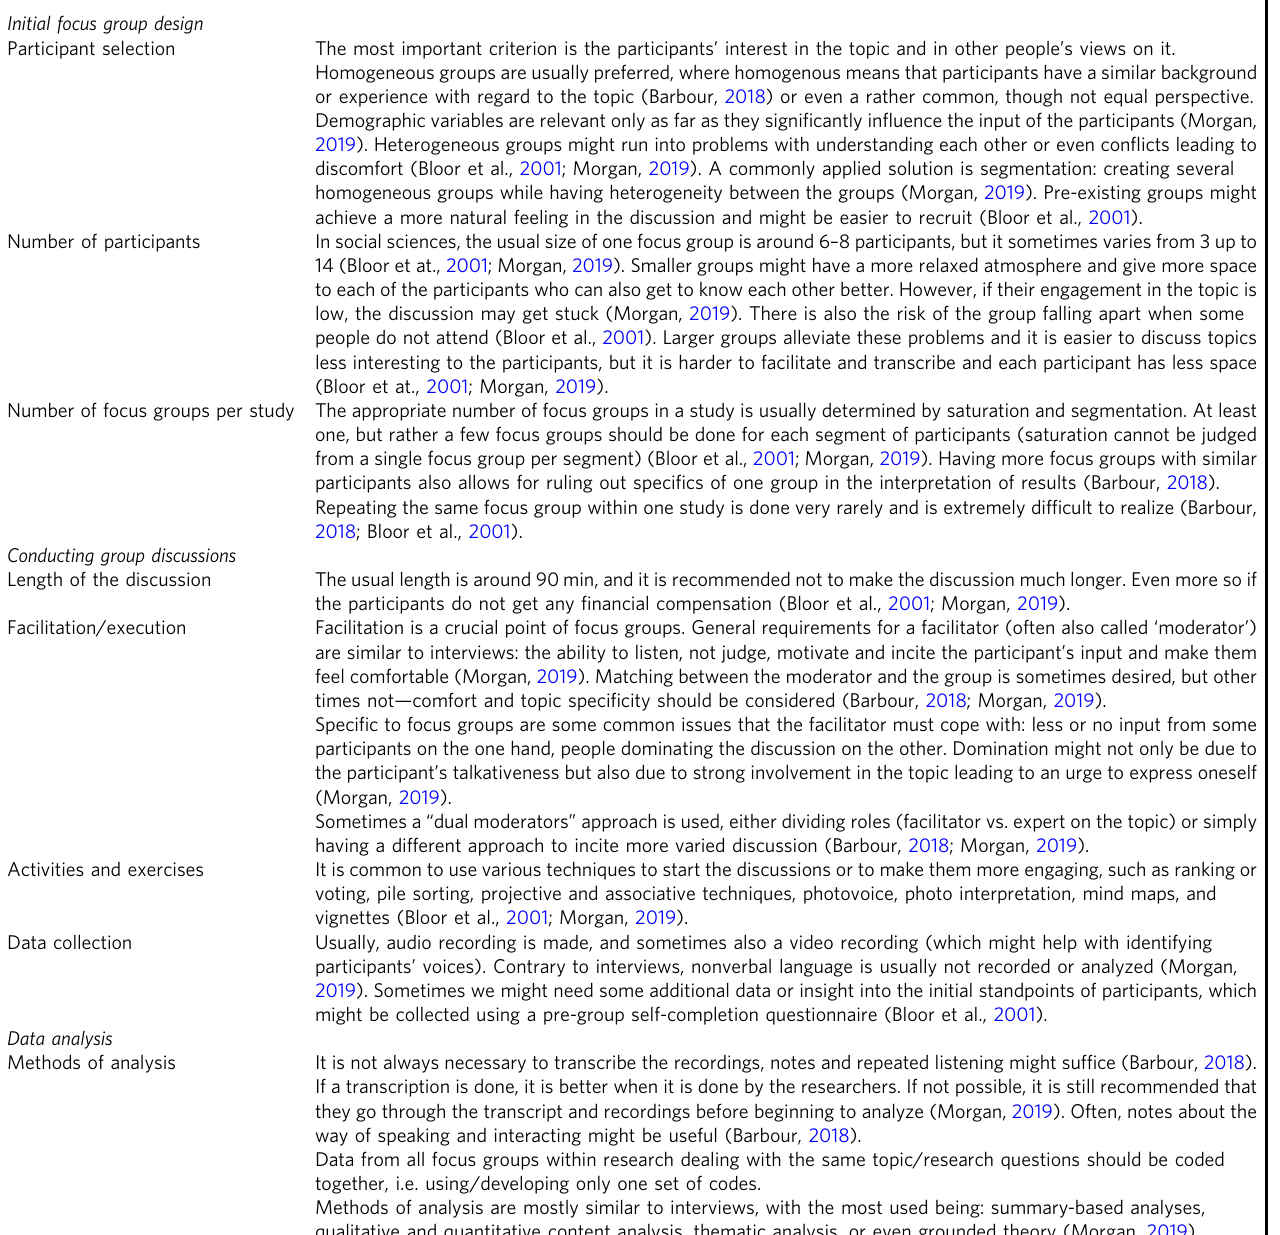
Table 1 Description of key characteristics and stages in a focus group